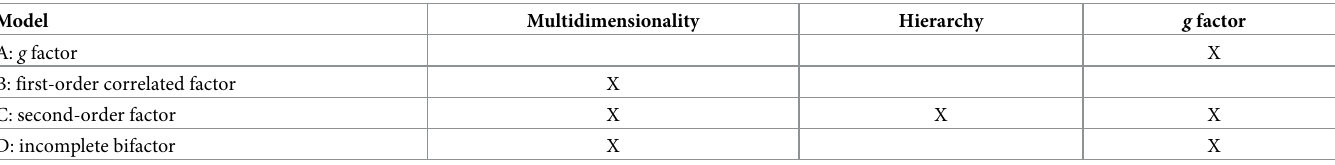
Table 2. Characteristics of the four different structural models. Model